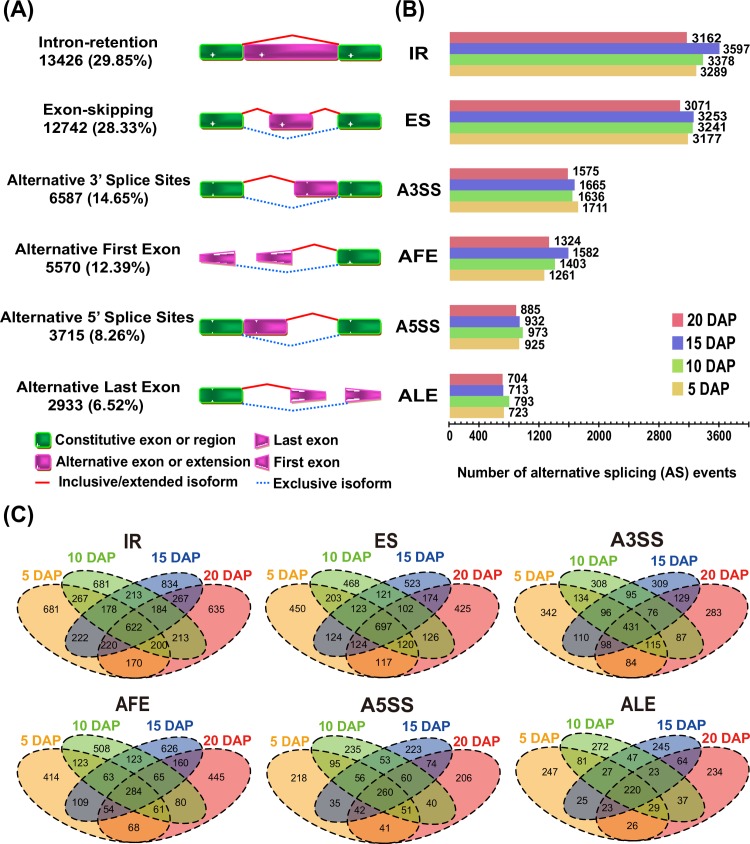
Overview and identification of AS events during endosperm development.(A) Alternative splicing (AS) events were categorized into the six most frequent types: alternative 3’ splicing (A3SS), alternative 5’ splicing (A5SS), alternative first exon (AFE) splicing, alternative last exon (ALE) splicing, intron retention (IR) and exon skipping (ES). The total number of all types of AS events and their frequencies are shown; these numbers include newly identified and annotated AS events. (B) The bar chart presents the number of AS events detected at the four developmental stages. (C)The Venn diagrams depict shared and unique AS events among the four developmental stages of maize endosperm.